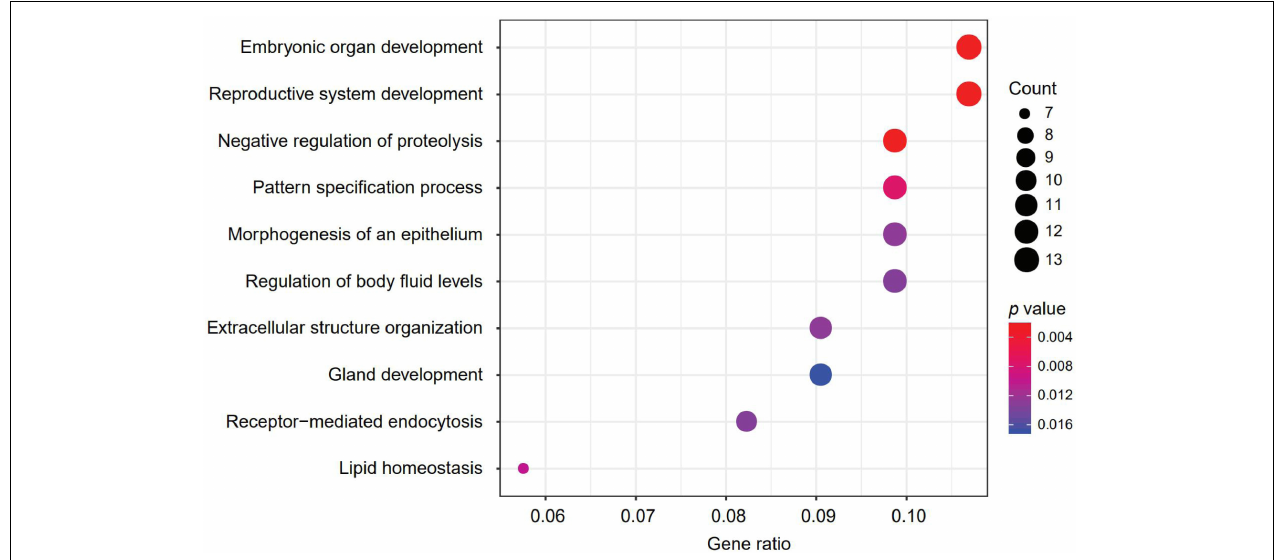
FIGURE 4 | The most represented biological processes associated with our signature genes. Dot plot displaying the number of signature genes involved in each biological process, determined by enrichment analysis. Dot size represents the number of genes, and dot color represents p -value; a lower p -value represents a higher probability of a biological process being enriched with the signature